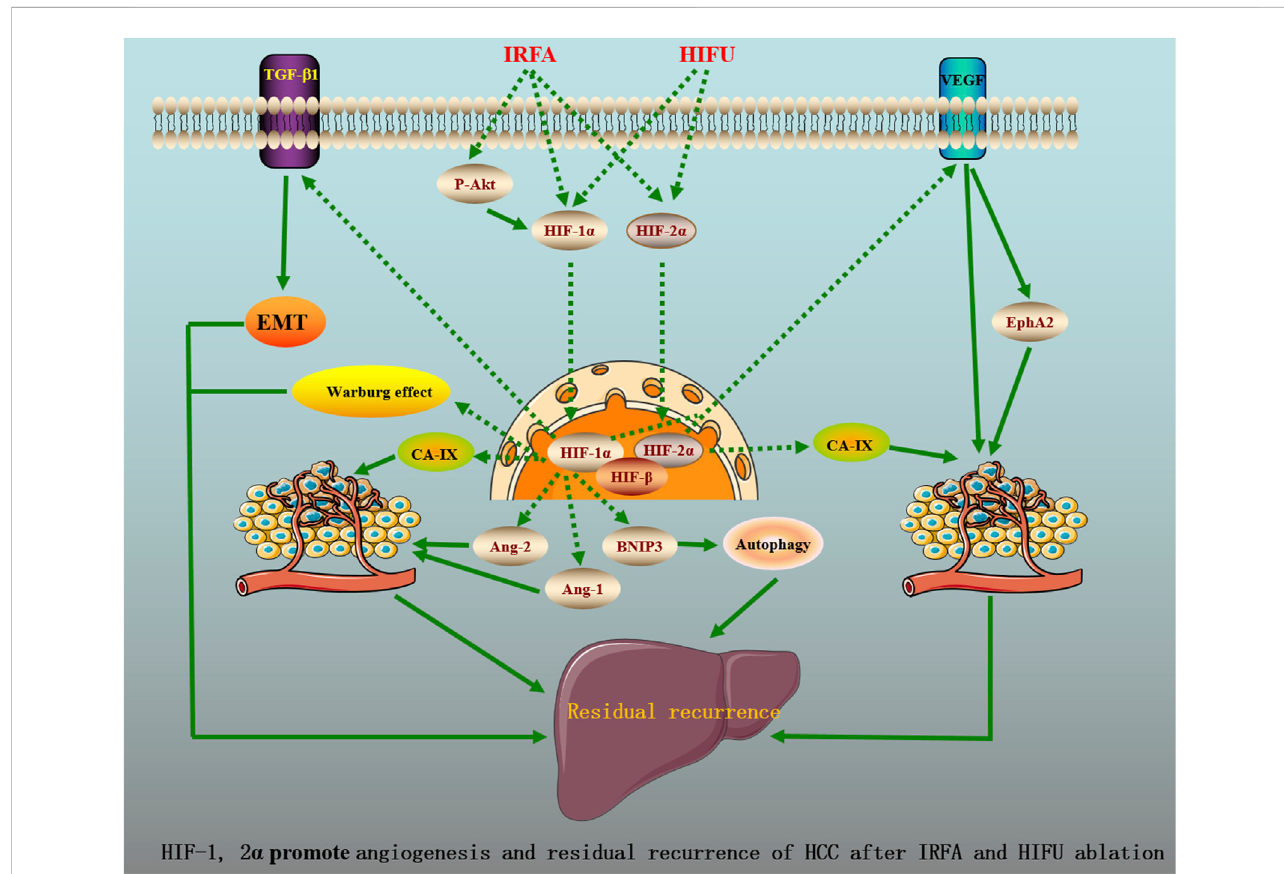
HIF-1, 2a promote angiogenesis and residual recurrence of HCC after IRFA and HIFU